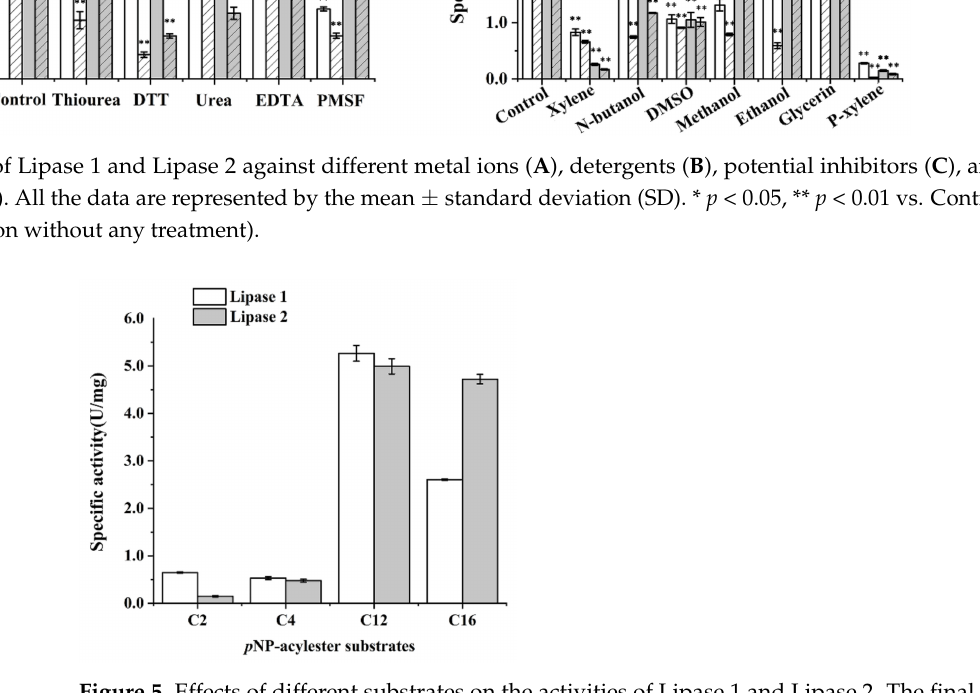
Figure 5. Effects of different substrates on the activities of Lipase 1 and Lipase 2. The final enzyme concentration in each reaction was 0.5 µ g/mL. C2, p -nitrophenyl acetate; C4, p -nitrophenyl butyrate; C12, p -nitrophenyl laurate; C16, p -nitrophenyl